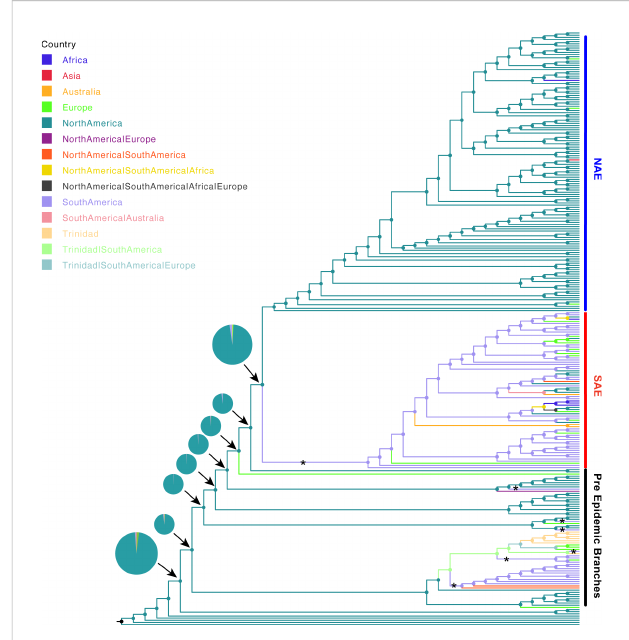
FIGURE 3 Ancestral state reconstruction of S. aureus isolates. Ancestral state reconstruction was done using log likelihood restricted maximum a posteriori analysis of the phylogenetic tree with the classi fi cation of each sequence based on collection location. Branches are colored according to the most probable location state of their descendant nodes as indicated at the legend. “ * ” indicates introduction from North America to South America. The pie charts show the probability of location for each common ancestor on the major branch leading to the NAE and SAE